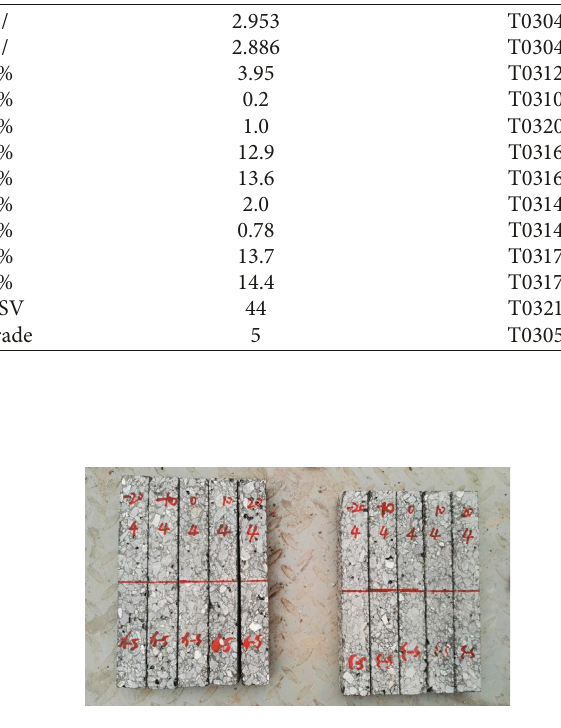
Figure 2: Single-edge notch beams.